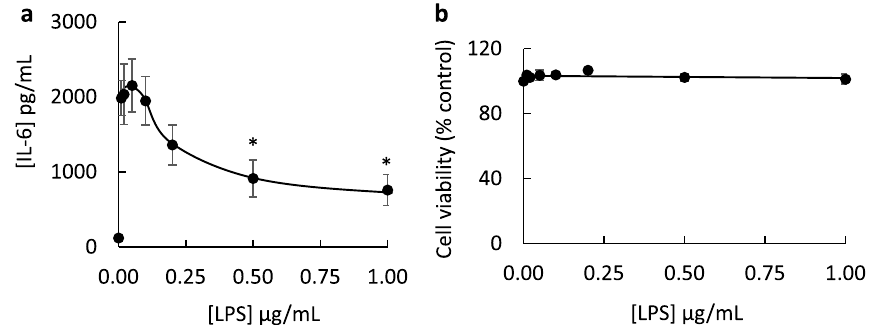
Figure 4. Effect of lipopolysaccharide (LPS) on IL-6 secretion by fibroblasts ( a ) and fibroblast viability ( b ). Peak IL-6 production was observed to 0.05 µg/mL LPS, with declining response at higher concentrations ( a ). Cell viability was unaffected by LPS at concentrations up to 1.0 µg/mL, determined by MTT assay ( b ). Data are mean ± SEM; * p < 0.05; ( a ) n = 3; ( b ) n = 4–5. Statistical analysis was performed using a Student’s t test.